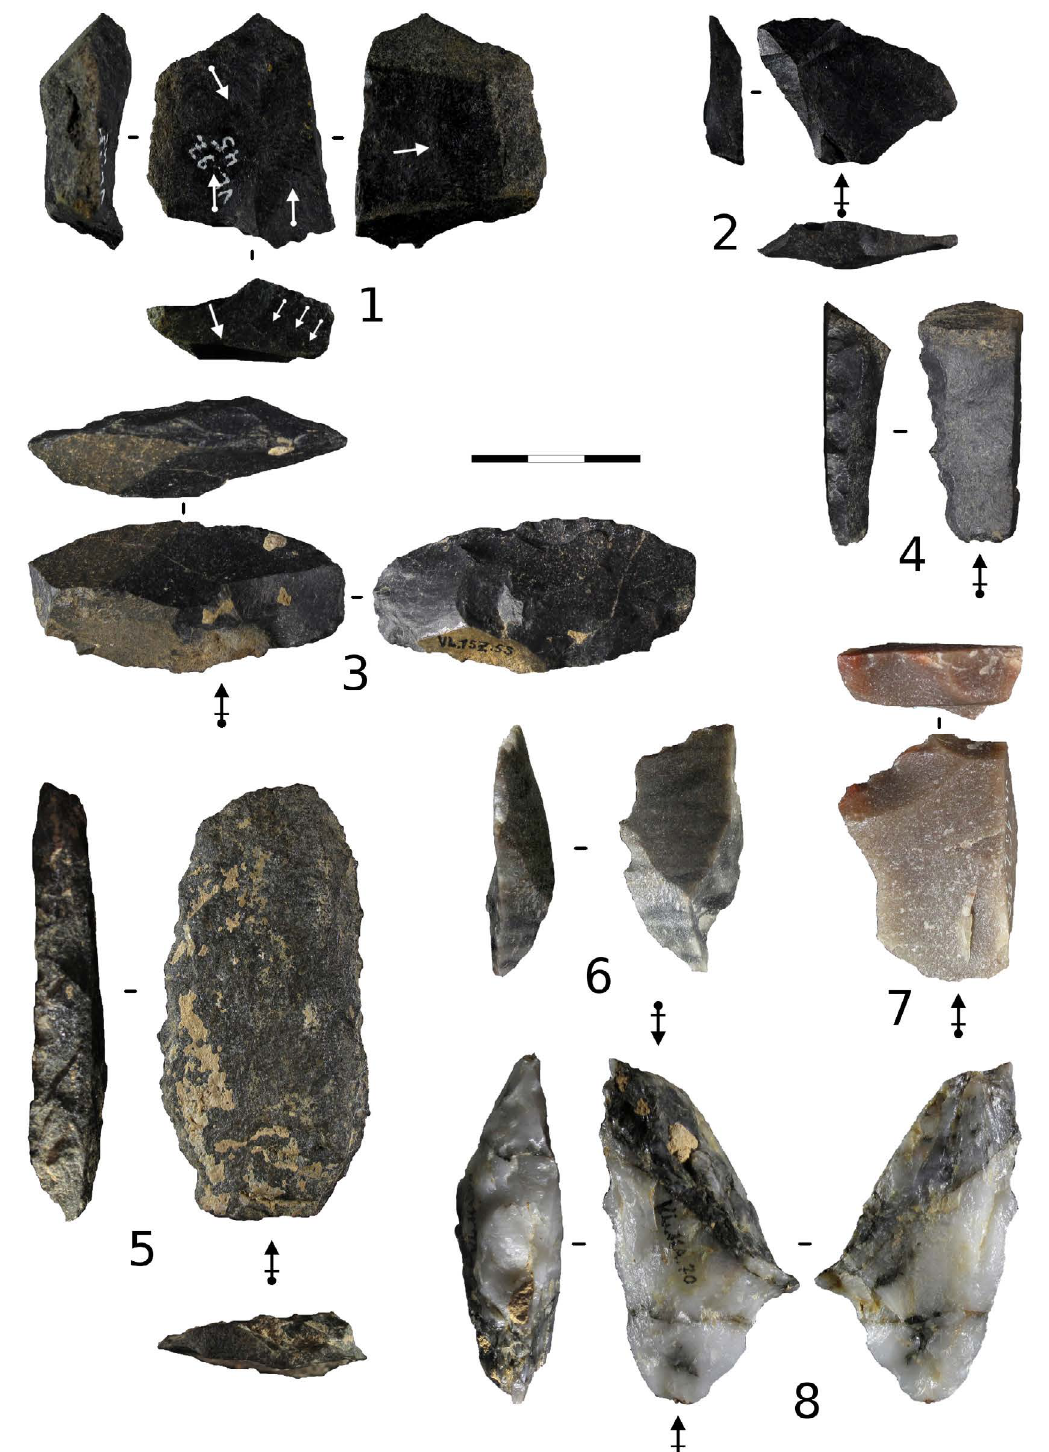
Figure 6. 1-4 Urgonian flint artefacts: 1: centripetal core; 2: Pseudo-Levallois point; 3: Transversal side-scraper made on ventral surface; 4: Denticulate side-scraper. 5-7: Quartzite artefacts: 5: Denticulate side-scrapers; 6-7: Denticulate. 8: Quartz flake obtained by bipolar percussion transformed into a denticulate side-scraper. The scale bar is 3